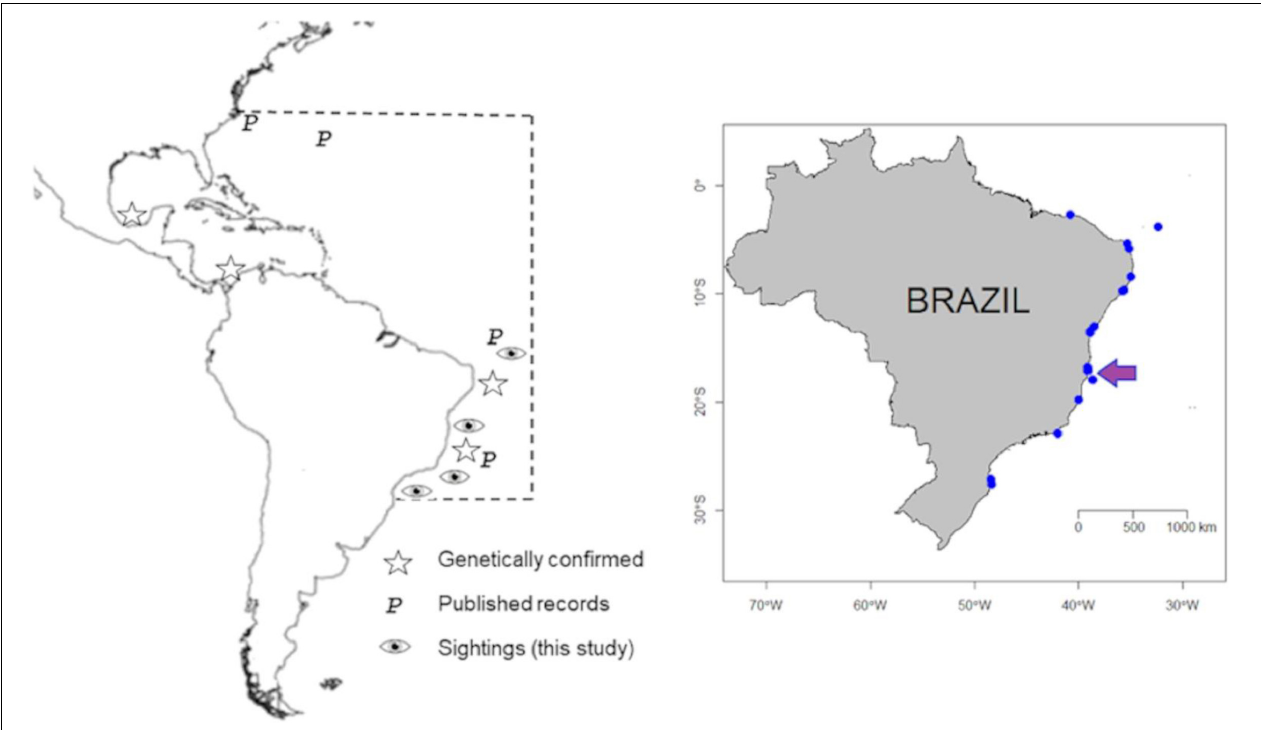
FIGURE 1 | Callistoctopus furvus . Left: putative occurrence area on the western Atlantic (boxed). Right: surveyed area, including neotype and voucher specimens site locations (arrowed). Blue dots refer to localities where personal interviews were conducted.